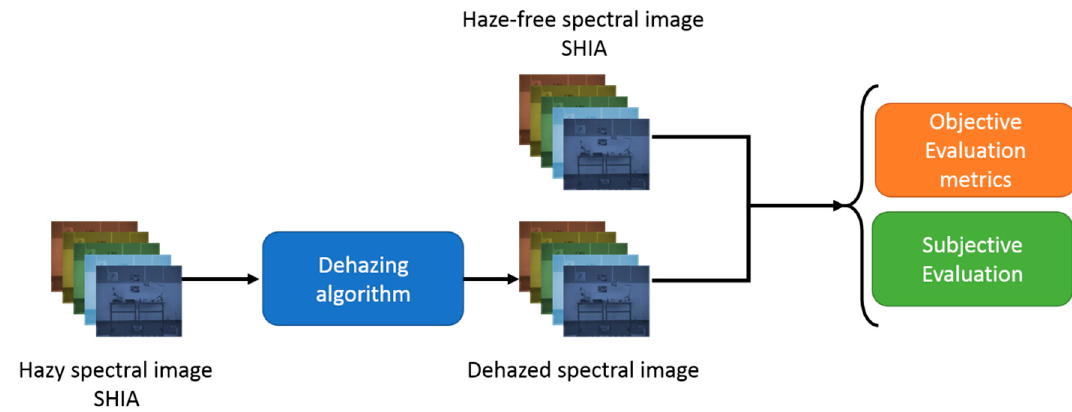
Figure 2. Workflow for the objective and subjective evaluation.